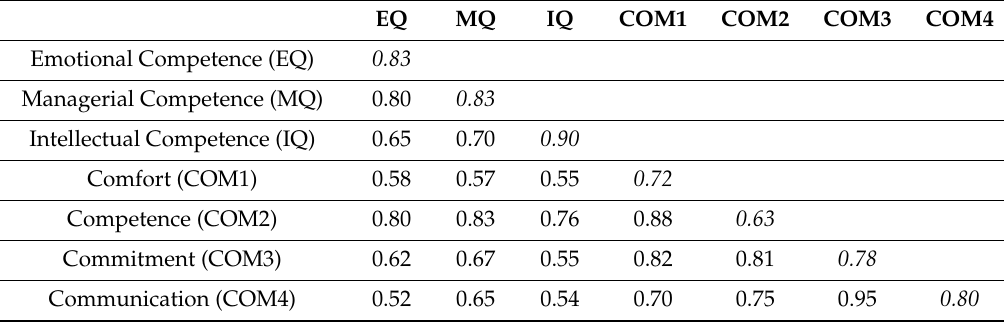
Table 5. Results of discriminant validity.